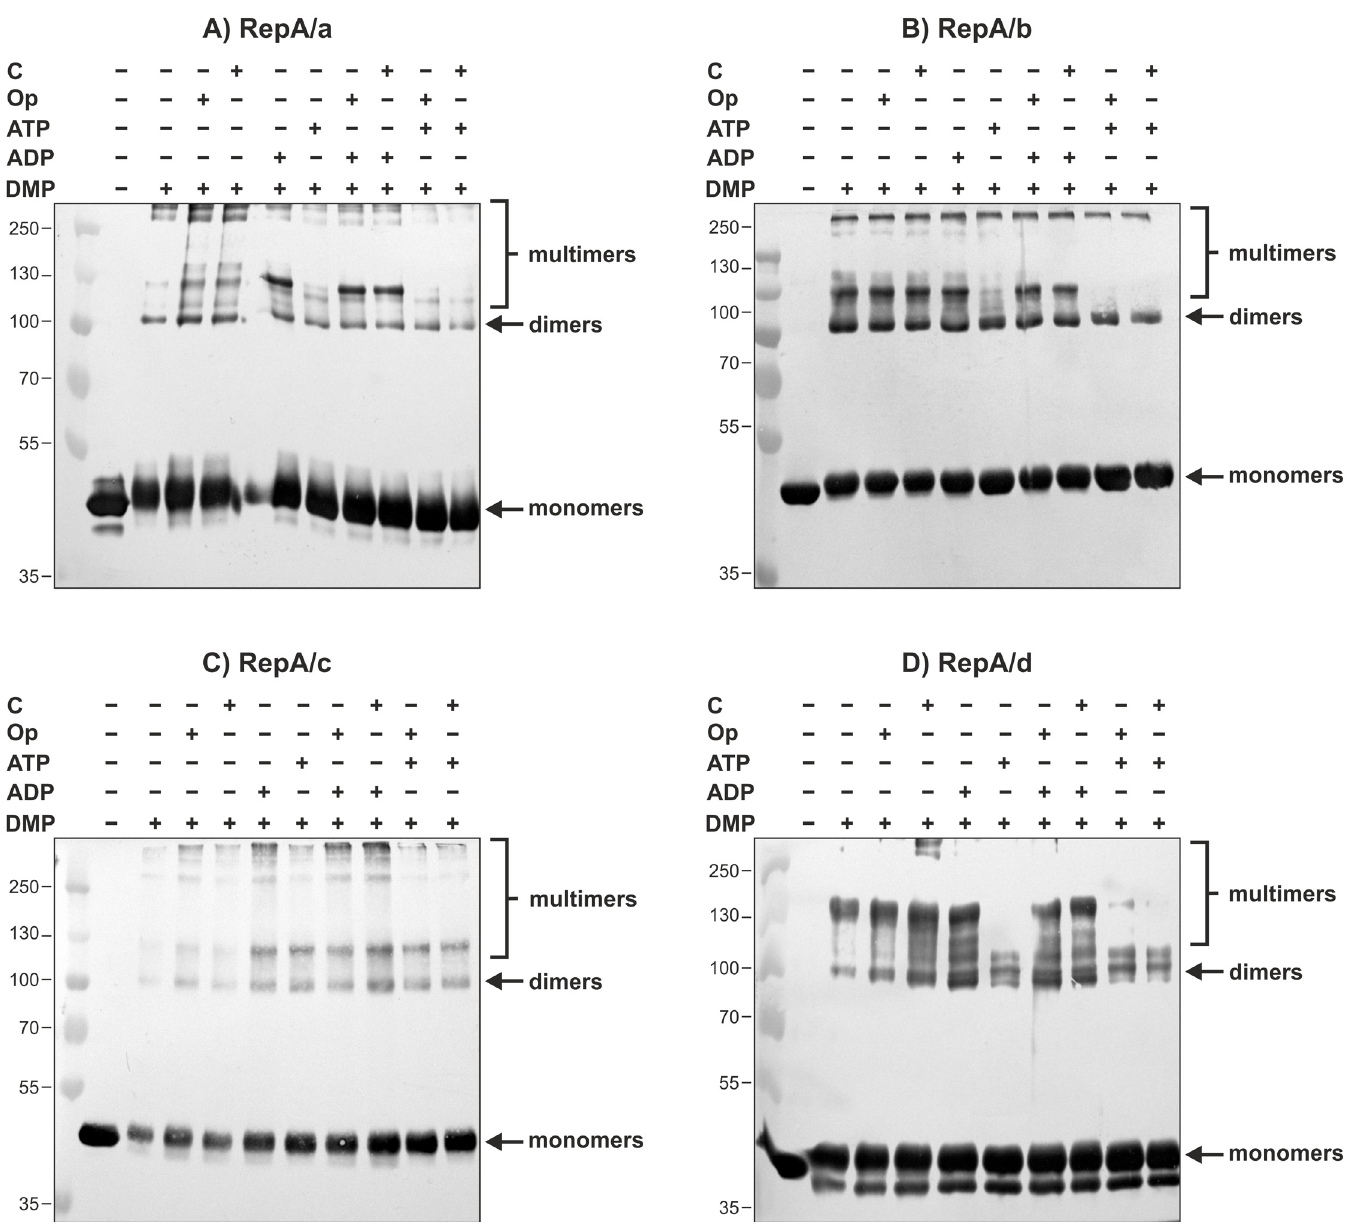
Fig 8. Oligomerization pattern of His 6 -RepA/a-d in the presence of ADP/ATP, specific and nonspecific DNA. Western blots are showing the products of cross-linking of individual His 6 -tagged RepA proteins (0.1 – 0.2 nM), following 1 h incubation at 28°C with 10 mM DMP and additional compounds. '+' means the presence of: 'C' — nonspecific DNA competitor (10 – 50 ng); 'Op' — specific operator DNA (10 – 50 ng); ADP (2 mM) or ATP (2 mM). The thin lines indicate the marker bands whose molecular masses are expressed in kDa. Arrows indicate different species formed by RepA proteins corresponding to monomers and dimers, while the position of multimers was marked with